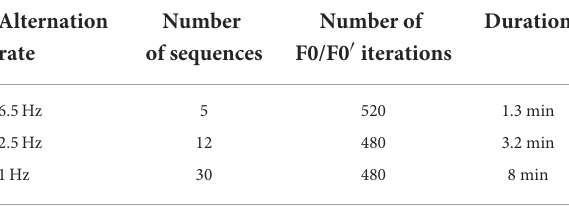
TABLE 1 Summary of the stimulation metrics for all three alternation rate, at one F0 change. Alternation Number Number